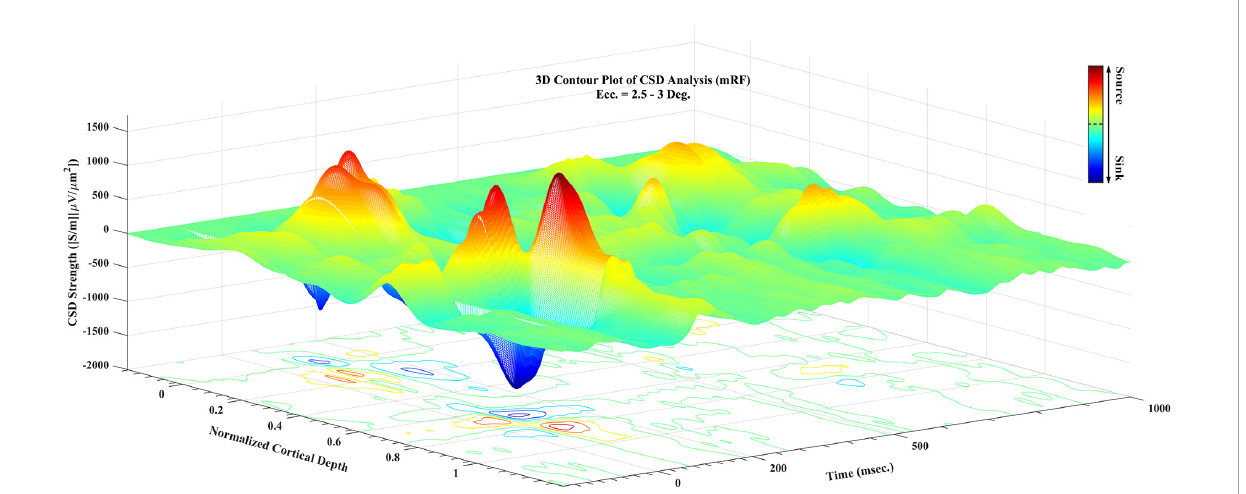
FIGURE4 A 3D contour plot of current sinks and sources (CSD) during visual stimulation. Cortical depth is normalized for better understanding. Sampling time in all recording times is presented. The third axis shows the CSD value, with the positive values referring to sources and negative values to sinks. The guide bar explains the colors of the